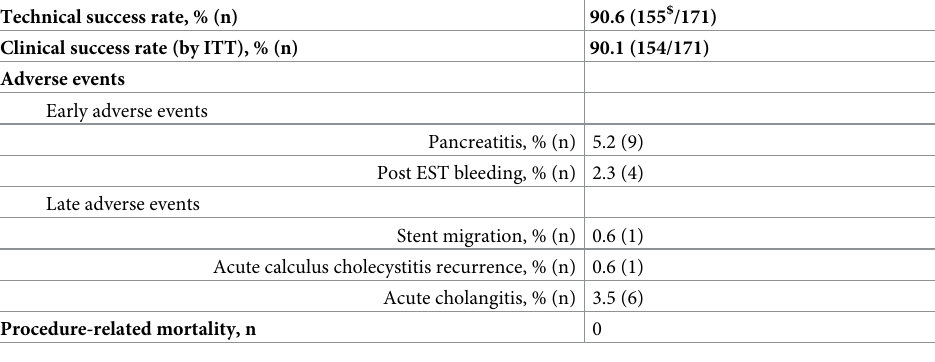
Table 2. Outcomes of endoscopic transpapillary gallbladder drainage (n = 171).